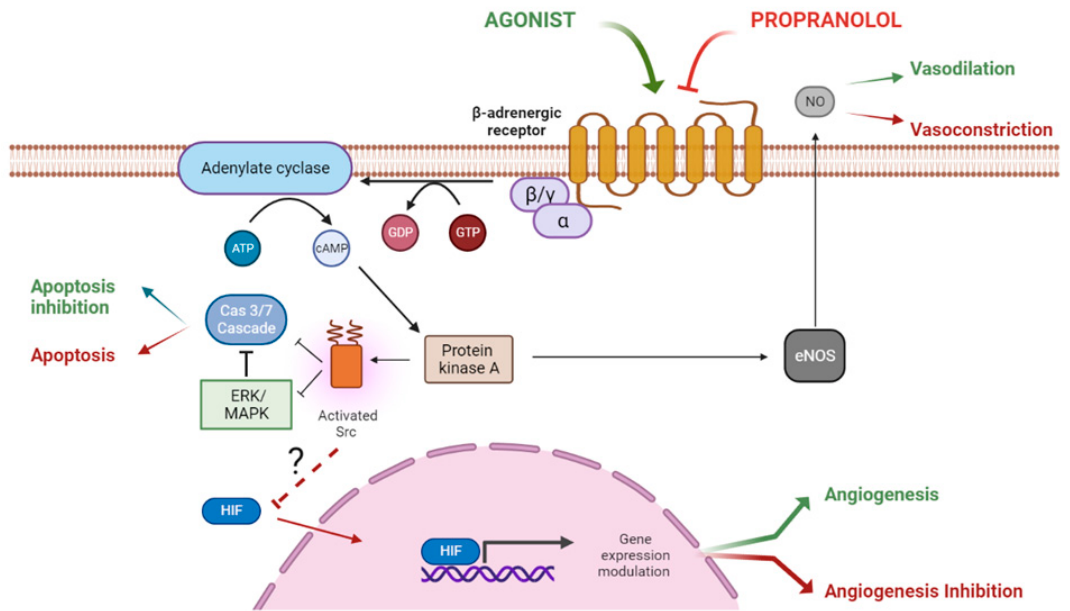
Figure 2. The ADBR signaling in the presence of the ligand, which will be blocked by propranolol. According to this model, propranolol would decrease the adenylate cyclase activity, decreasing the cAMP levels and the activation of PKA. Activation of eNOS by PKA will be reduced, leading to vasoconstriction (1). On the other hand, the decrease in PKA activity will affect src impairing the HIF-1 nuclear translocation with the downregulation of its nuclear targets, among them pro-angiogenic genes, such as VEGF (2). The decreased phosphorylation of the ERK/MAPK kinases cascade and Src will activate the caspase cascade, leading to apoptosis (3).